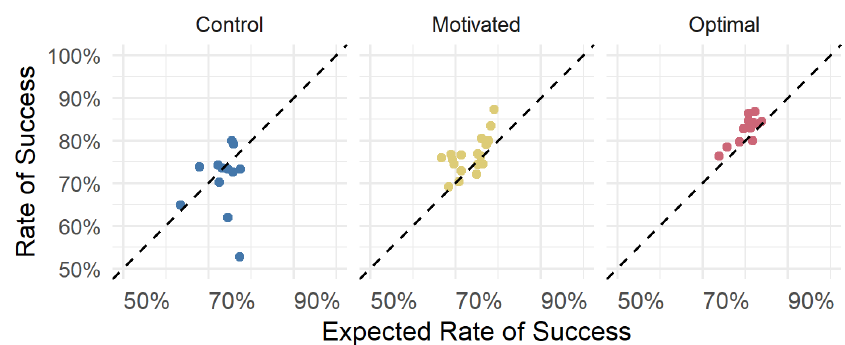
Figure 7. These scatter plots show a point for each participant’s actual rate of success and how it relates to their expected rate of success. The dashed line is a line with slope 1 going through the origin which would represent a 1:1 relationship (i.e., they performed as well as would be